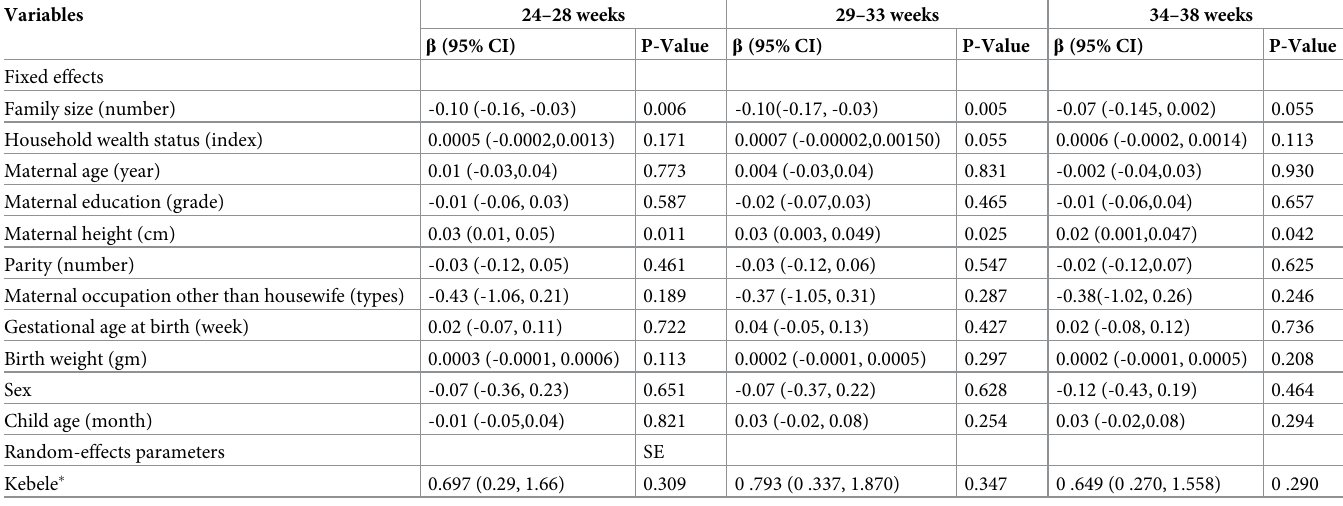
Table 6. Multilevel, mixed-effects regression coefficients for association of household, maternal, fetal, and child characteristics with weight-for-length z-score among children aged 11–24 months in Adami Tullu district, 2018.